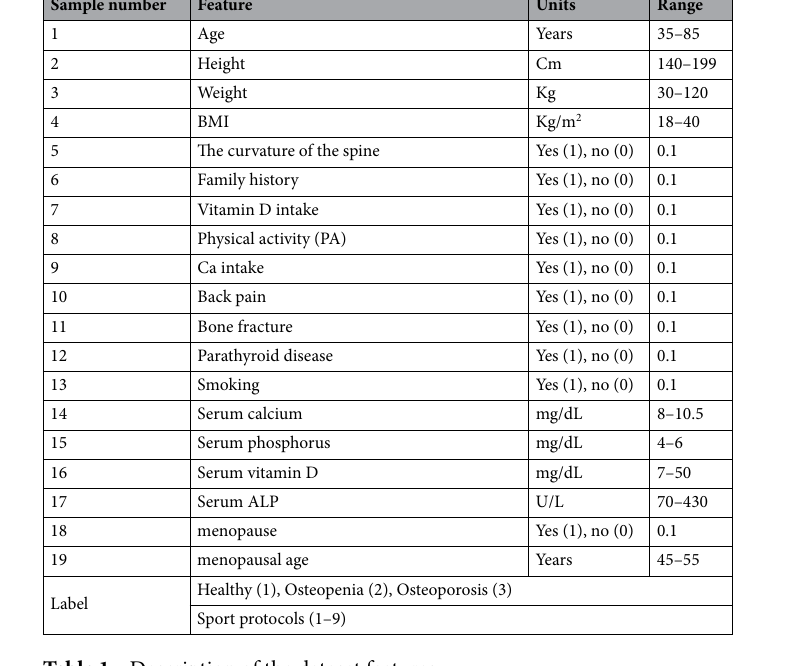
Table 1. Description of the dataset